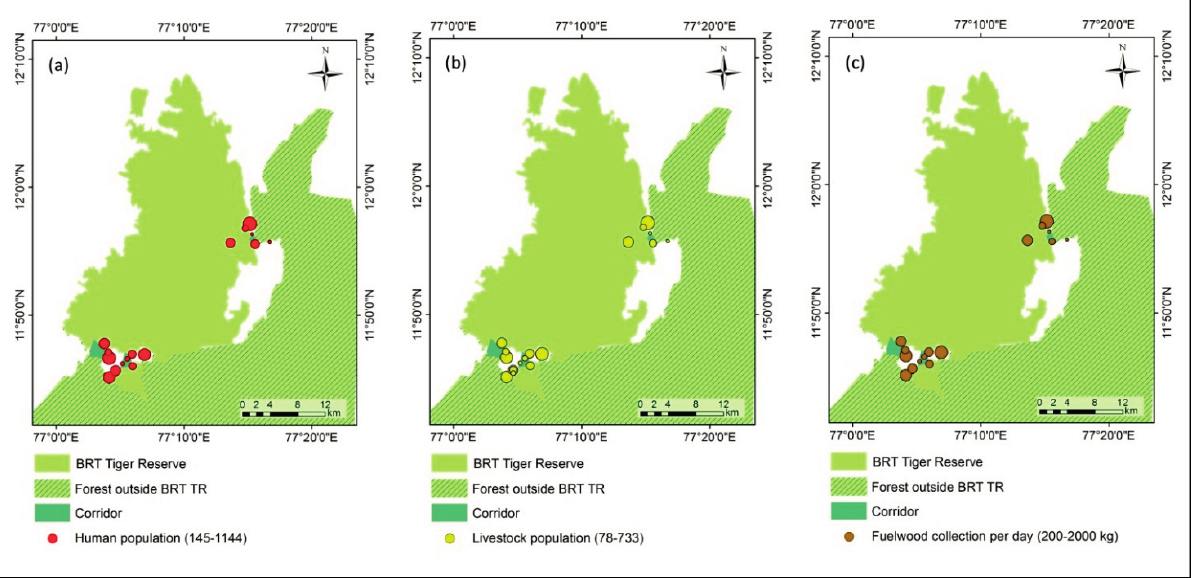
Figure 9. Mean (± se) annual income per household in INR (1 USD = 60 INR, date 15 July 2014) from fuel wood collection and NTFP (non-timber forest products) collection between three corridors of BRT. ( n = 31, 39 and 30 households from Punajanur corridor (PC), Mudalli corridor (MC) and Edeyarahalli corridor (EC), respectively). Human population, livestock population and extent of fuel wood collection at village level were mapped to understand the relative disturbance level between the corridors (Figure 10). Information related to NTFP collection was not mapped because in 2007 the State Forest Department banned NTFP collection in BRT for commercial purpose. However, NTFP is collected at minor scale only for domestic consumption, which contributes to approximately 3% of their total income [61].